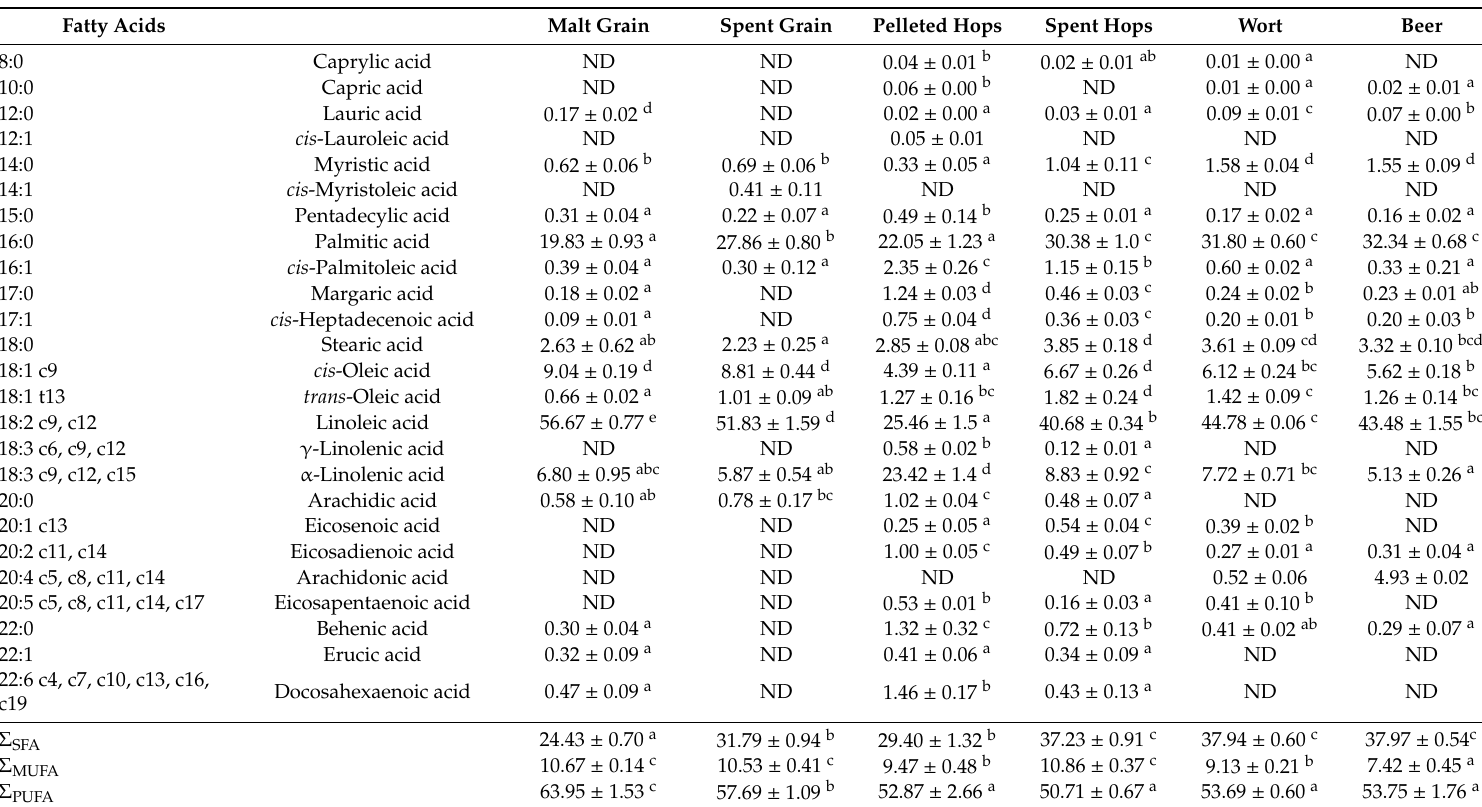
Table 2. The fatty acid profile and volatile compounds detected in the total polar lipid (TPL) extracts of each sample are expressed as a percentage of the total volatile components detected by GC-MS (mean ± SD, n =